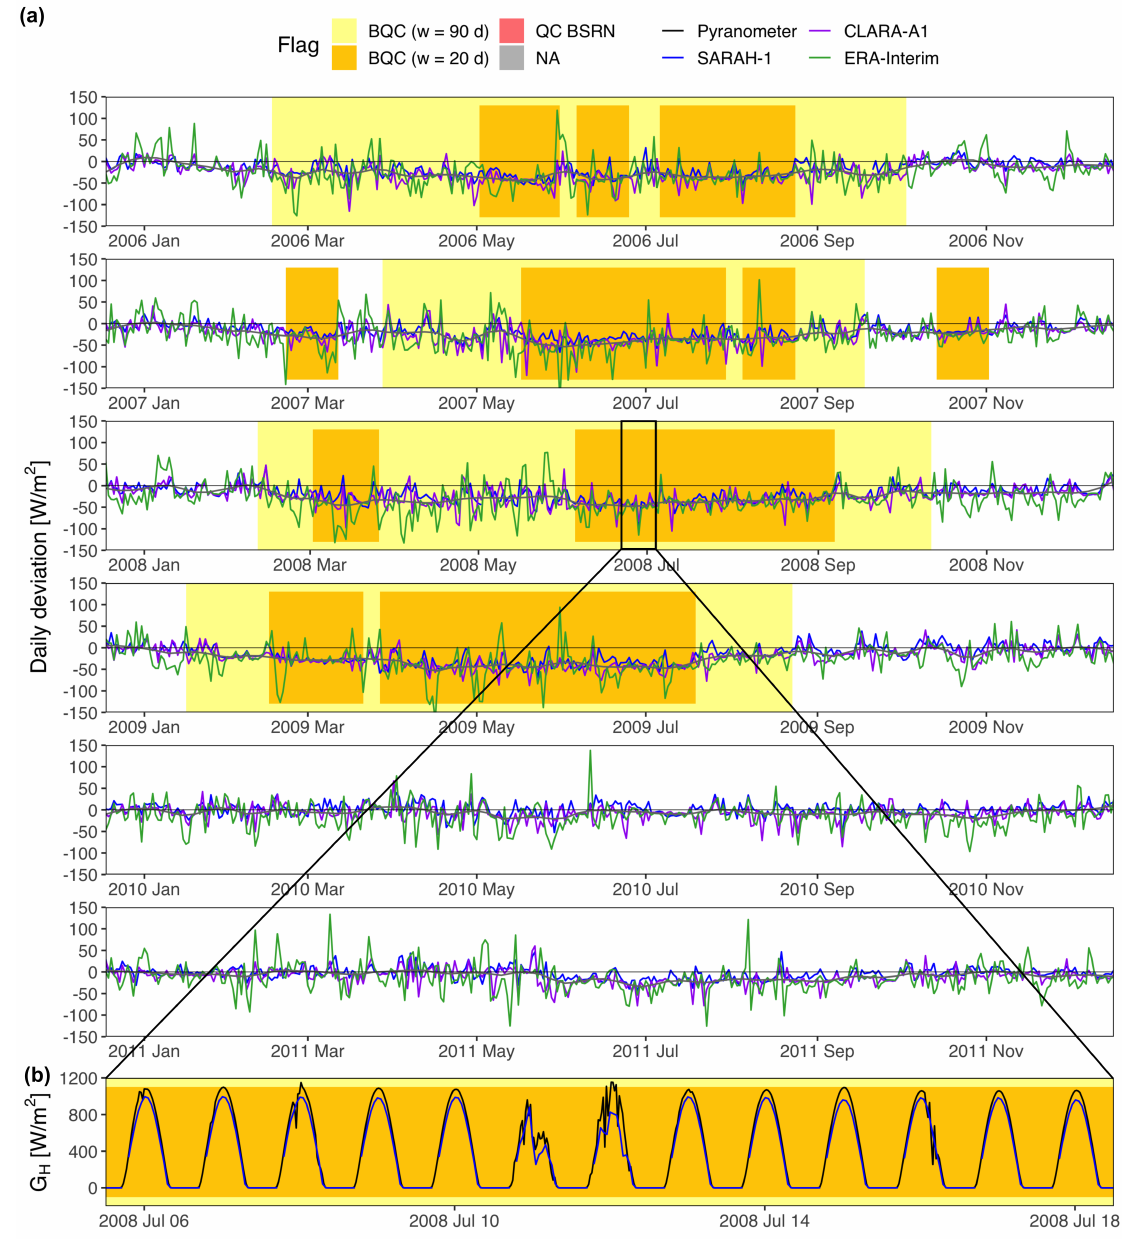
Figure 5. Incorrect photodiode calibration at SIAR ZA05 station. ( a ) Daily deviations (estimations-measurements) of the radiation databases. The gray line is a smoother of the deviations from the three databases; ( b ) Instantaneous G H from SARAH-1 and the